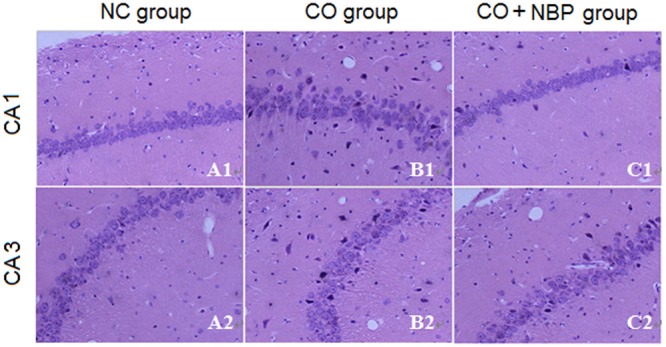
Pathological changes of hippocampus in NC, CO poisoning and CO+NBP treatment groups using HE staining. Neurons in CA1 region were smaller accompanied by either round or oval shape, and were aligned neatly and tightly (A1), while those in CA3 (A2) were larger than in CA1 region and did not arrange in order. Meanwhile, few nuclear karyopyknosis and fragmentation were detected in NC samples. Neurons in both CA1 (B1) and CA3 (B2) regions in CO group were irregular shape, and part of which was pyknosis and shrinking with spindle shape. Neuronal body was roughly normal in both CA1 (C1) and CA3 (C2) regions in CO+NBP group.